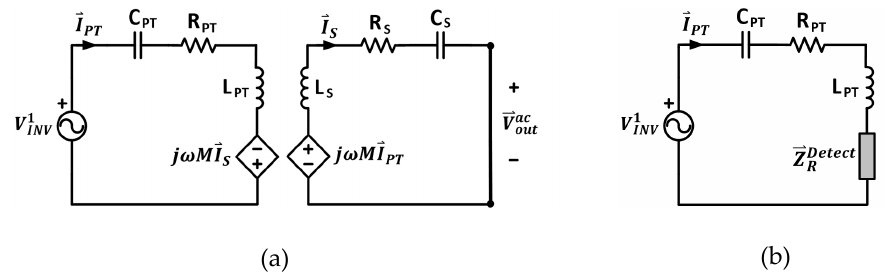
Figure 8. Simplified equivalent circuit of the proposed system when operated in detection mode: ( a ) Overall circuit; ( b ) Reflected impedance in primary circuit.